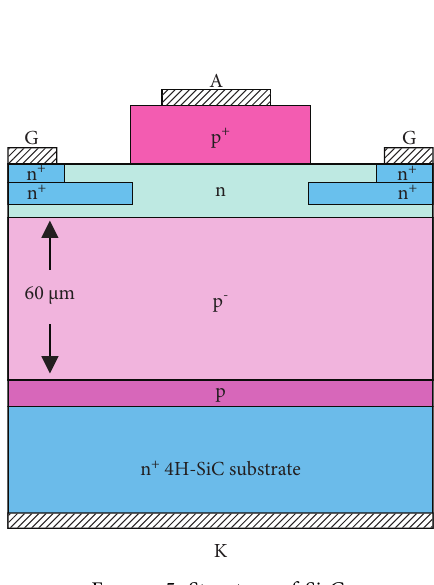
Figure 4: Diagram of DMOSFET.